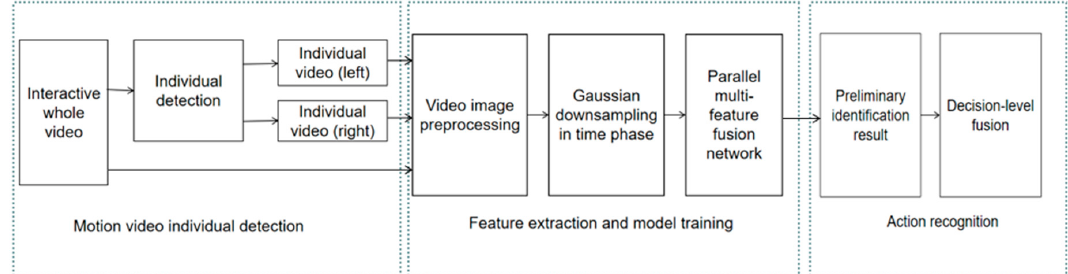
Figure 1. Human interaction recognition based on whole–individual detection.